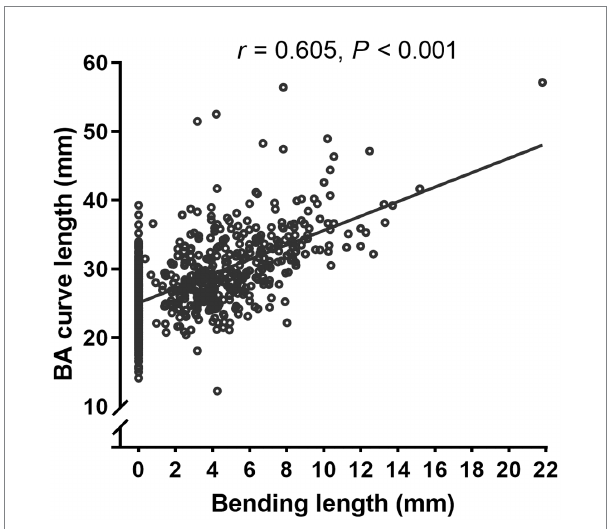
FIGURE 3 Pearson correlation analyses showed a positive correlation between BA curve length and BL ( r = 0.605, p <